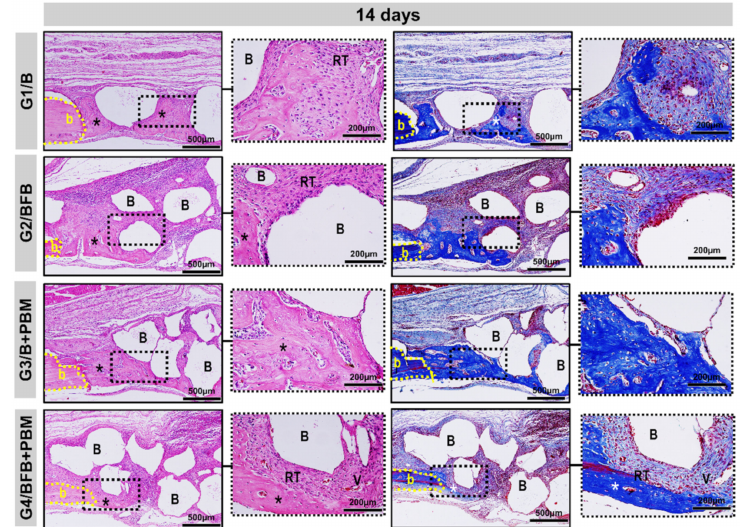
Figure 7. Details of the evolution of the bone repair process of the cranial defects at 14 days filled with biomaterial (G1/B), biocomplex consisting of biomaterial plus heterologous fibrin biopolymer (G2/BFB), biomaterial and PBM (G3/B + PBM), and biocomplex consisting of biomaterial plus het- erologous fibrin biopolymer and photobiomodulation with low-level laser therapy (G4/BFB + PBM). The deposition of the osteoid matrix (asterisk) from the edges of the defect (b), particles of the bio- material (B) interspersed with densely cellular reactive connective tissue (RT) and vascular budding (V). HE and Masson Trichrome; original magnification × 10; bar = 500 µ m and insert, magnified images × 40; bar = 100 µ m.